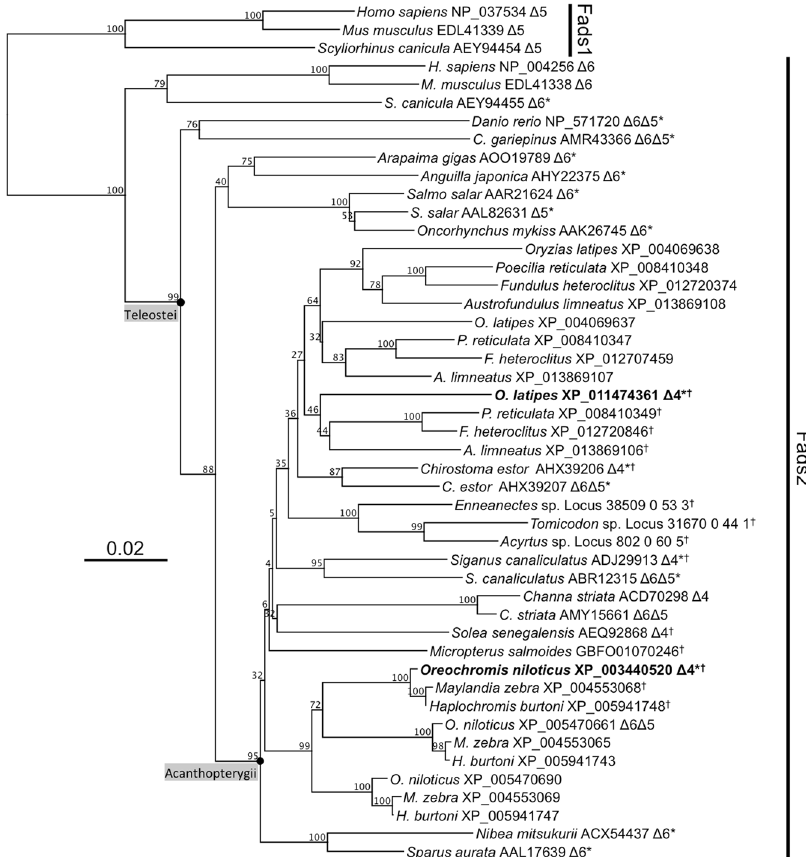
Figure 3. Phylogenetic tree comparing the amino acid sequences of teleost Fads2 with non-teleost vertebrate Fads-like from the cartilaginous fish and mammals (human and mouse). The numbers represent the frequencies (%) with which the tree topology presented was replicated after 1,000 iterations. The functionally characterised Fads were shown with their corresponding regioselectivity ( Δ 6, Δ 5, Δ 6 Δ 5 and Δ 4). Asterisks (“ * ”) indicate Fads2 that have been subjected to further functional analyses in the present study, including the newly cloned Δ 4 Fads2 from medaka ( Oryzias latipes ) and Nile tilapia ( Oreochromis niloticus ) highlighted in bold. Crosses (“†”) indicate Fads2 that possess the YXXN amino acid residues determining Δ 4 desaturase activity 32 . Branches including Teleostei and Acanthopterygii Fads2 sequences are